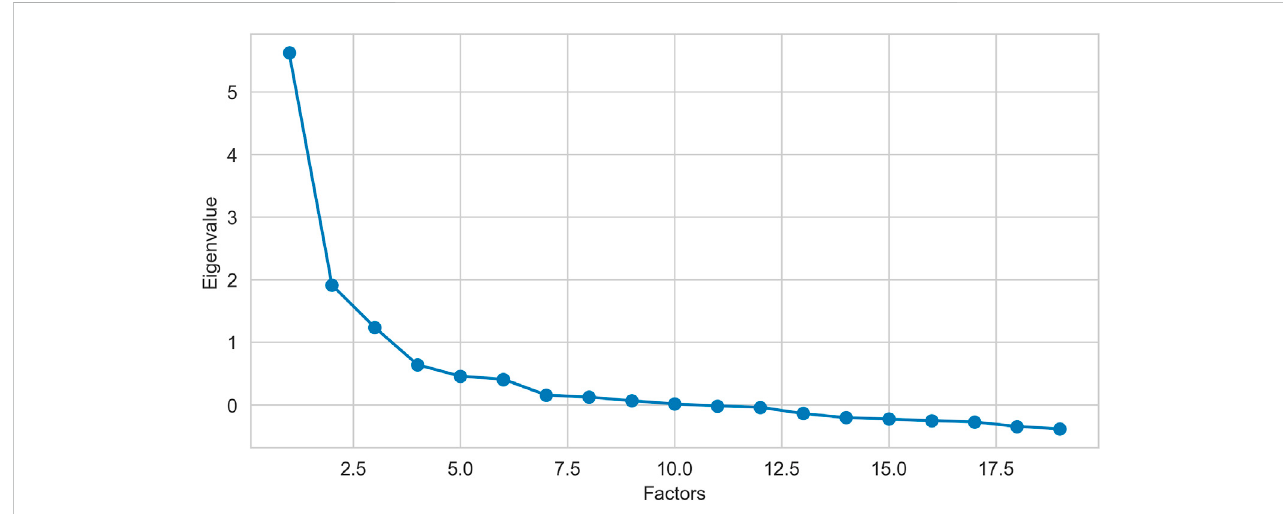
FIGURE 6 Scree plot of variance explained by each factor, resulting from the factor analysis on questionnaire items.